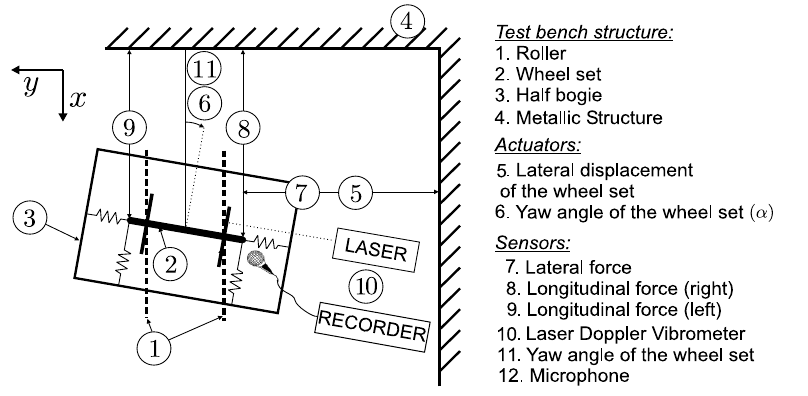
Fig. 4. Simpli fi ed top view of the scaled test